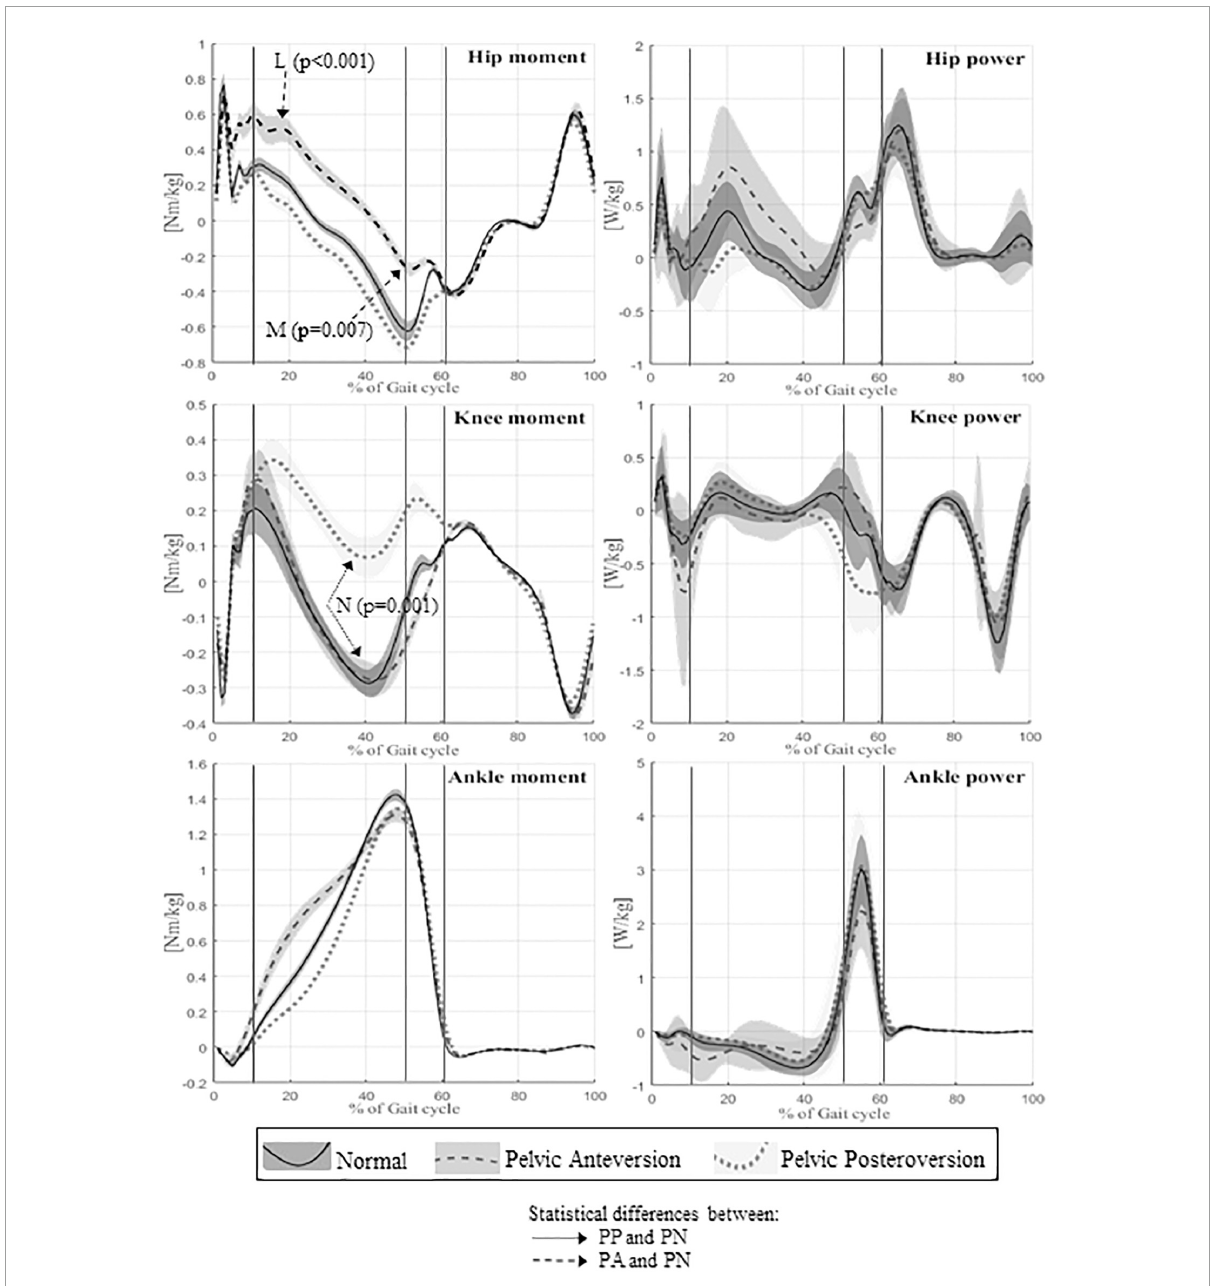
FIGURE3 Means and standard deviation of kinetics of lower limbs joints of the whole sample (on the left panel: hip, knee, ankle moments; on the right panel: hip, knee, and ankle powers). The units of measure are reported on vertical axis, the time of gait cycle in percentage on the horizontal axis. Continuous lines represent averaged group value of Normal gait, dashed lines represent averaged group value of Pelvic Anteversion gait, and dotted lines represent averaged group value of Pelvic Posteroversion gait. The shaded areas denote the standard deviation (SD), dark gray, normal gray, and light gray stand respectively for Normal, Anteversion, and Posteroversion. The three lines separate the first double support phase (first line), the single support phase (second line), and the second double support phase (third line). Dashed arrows represent statistical differences between PA and PN, dotted arrows represent statistical differences between PP and PN. L (Hip maximum flexion moment), M (Hip max extension moment), N (Knee extension moment).